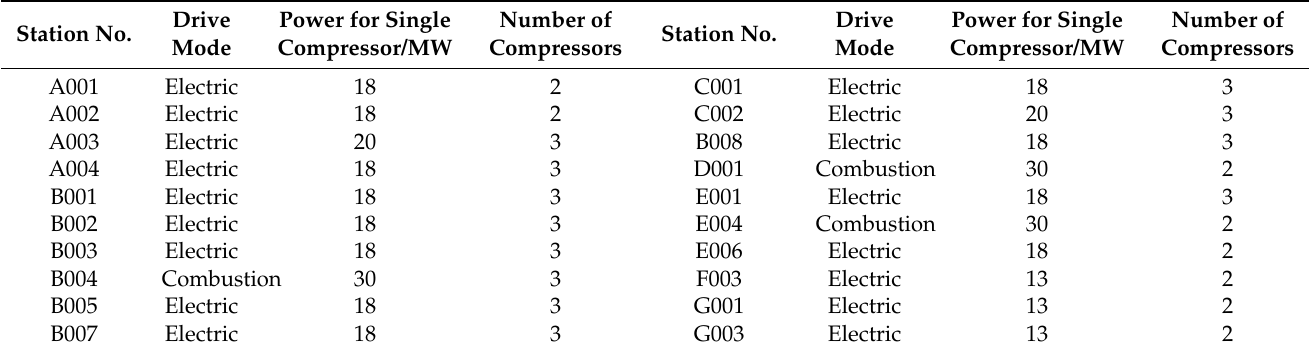
Figure 3. XYZ pipeline project. The square blocks represent the compressor station and the ellipse blocks represent the distribution station. The detailed information of the compressor station can be seen in Table 1. Table 1. Compressors under working conditions.